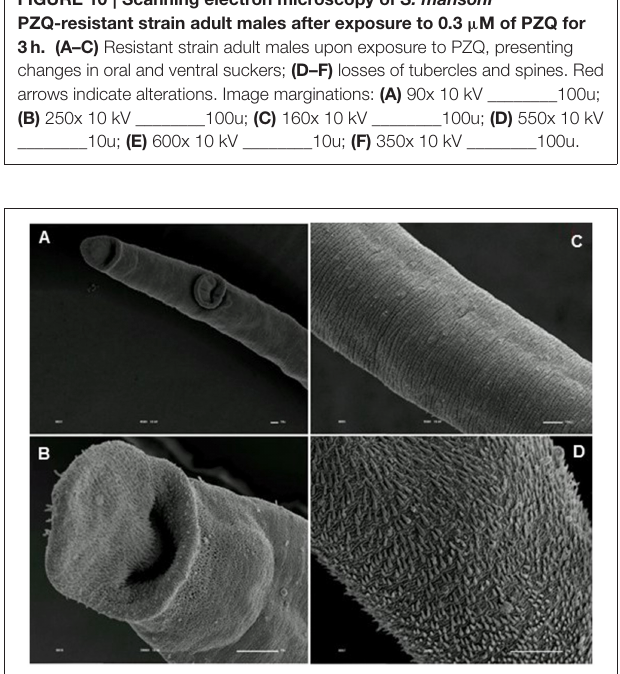
FIGURE 11 | Scanning electron microscopy of S. mansoni PZQ-resistant strain adult females of control group kept in RPMI-1640 drug free medium for 3 h. (A,B) Resistant strain adult females kept in RPMI-1640 drug free medium, showing normal morphology of the oral and ventral suckers; (C,D) normal morphology of the tegument. Image marginations: (A) 450x 10 kV ________10u; (B) 2000x 10 kV ________10u; (C) 950x 10 kV ________10u; (D) 2500x 10 kV ________10u.